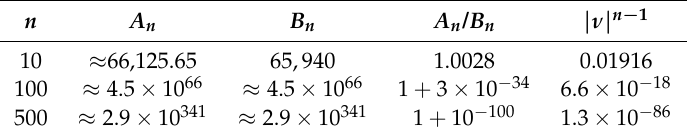
Table 2. Values A n / B n the magnitude of the relative error of asymptotic